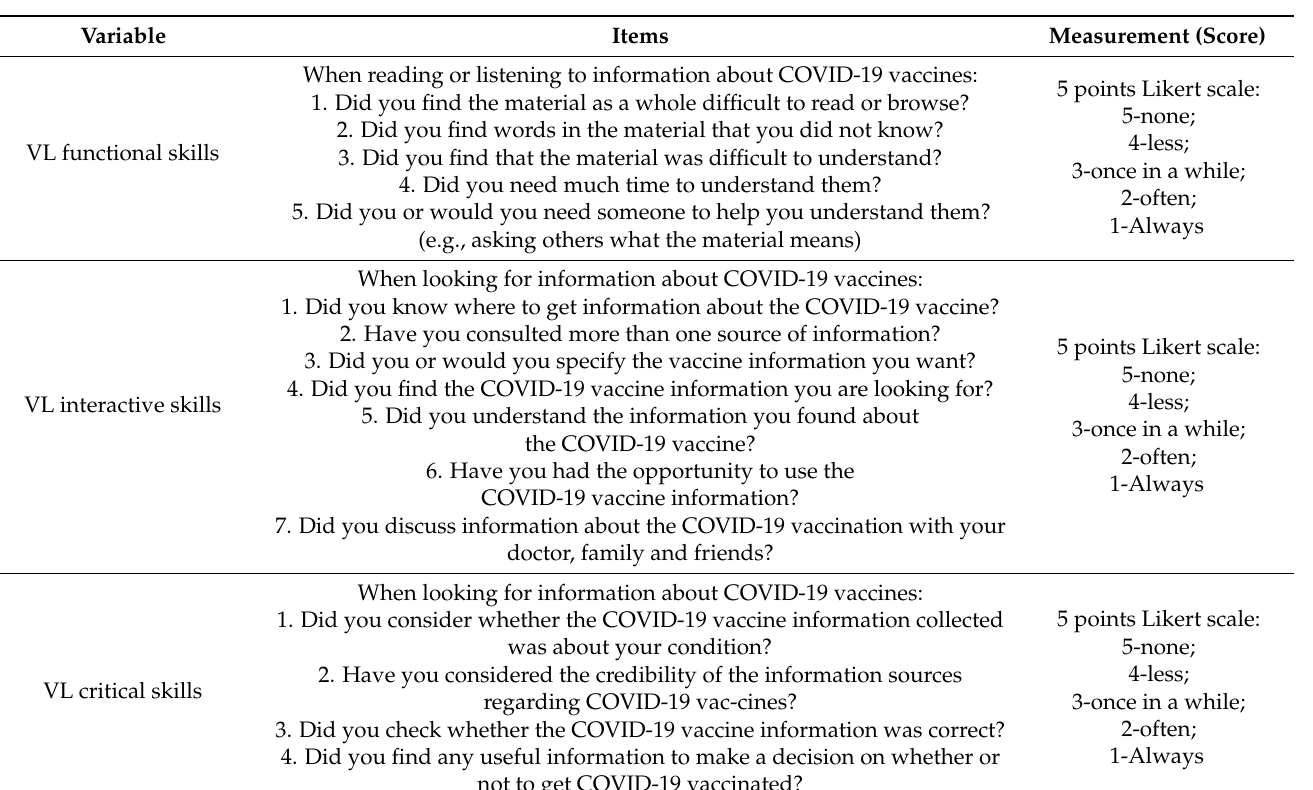
Table A1. The initial Chinese version of the COVID-19 vaccine literacy